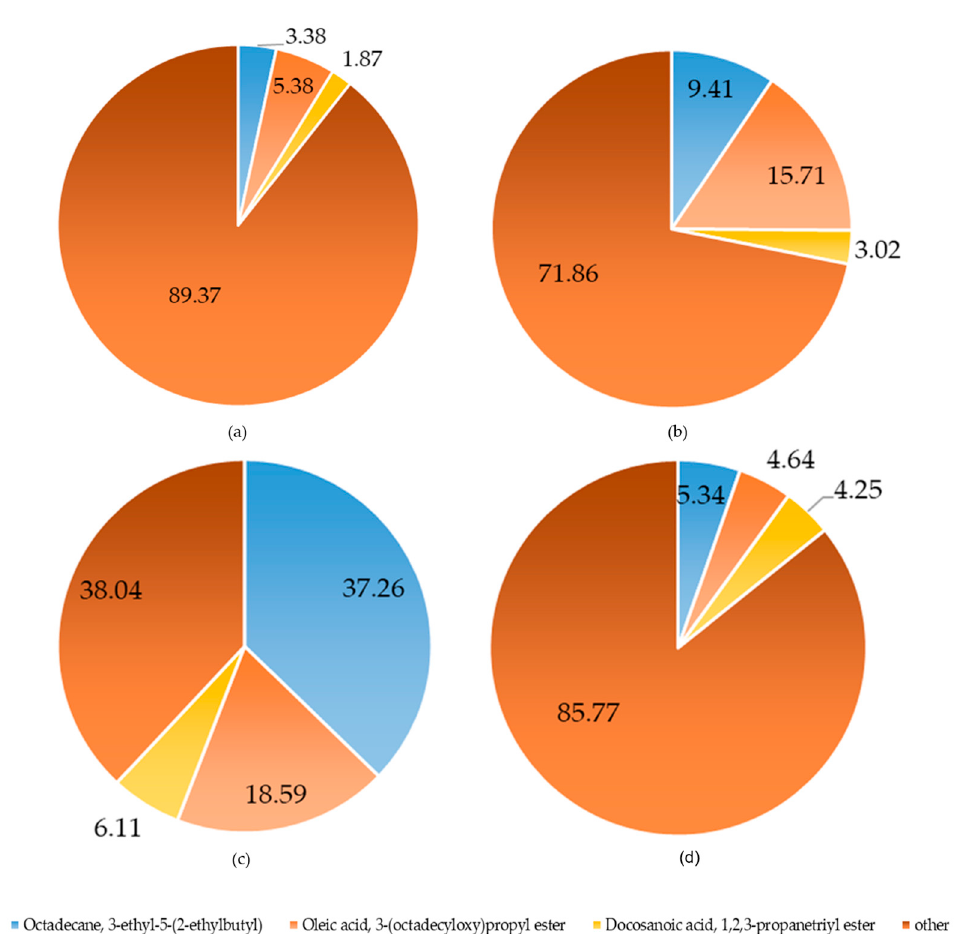
Figure 2. Chemical composition of volatile components in different A. sinensis organs: ( a ) peel; ( b ) blossom; ( c ) blade; and ( d ) seed. Table 2. Chemical composition analysis of different organs from A. sinensis .